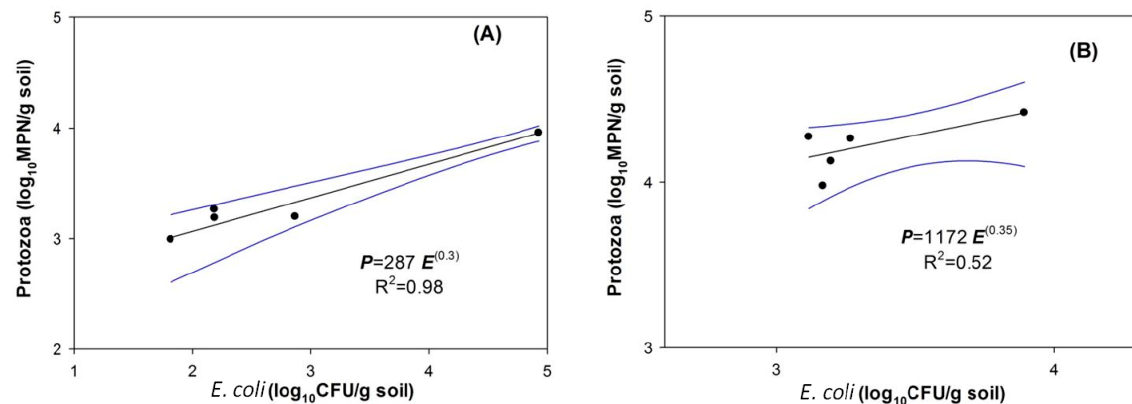
Figure 7. The correlation between protozoa abundance and attached E. coli along the filter depth. ( A ) NPG columns, ( B ) PEP columns.